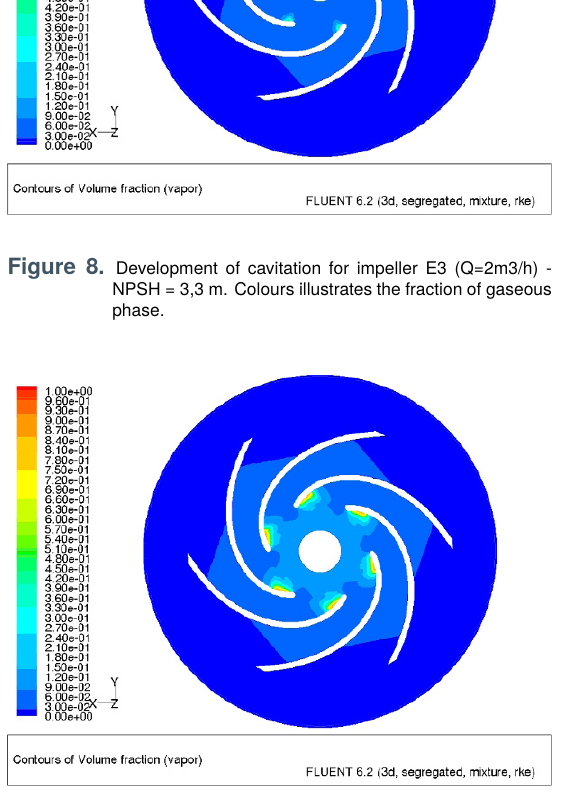
Figure 9. Development of cavitation for impeller E3 (Q=2m3/h) - NPSH = 2,3 m. Colours illustrates the fraction of gaseous